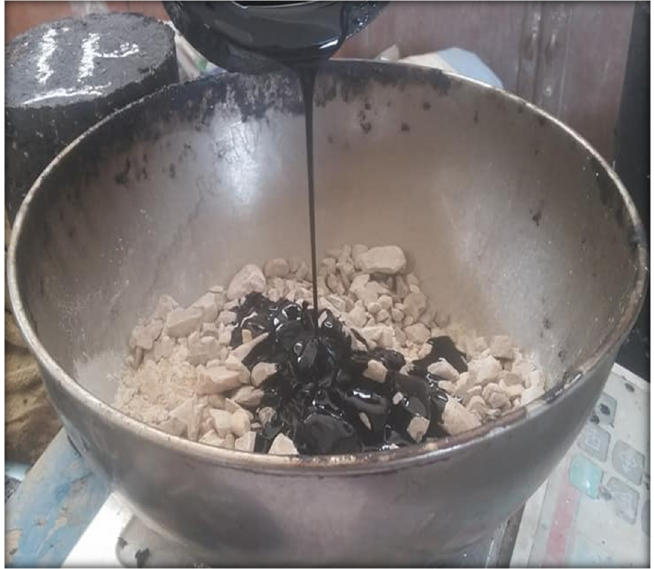
Figure 2. Adding bitumen to aggregates.